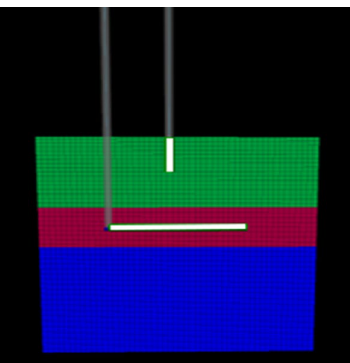
Fig. 2 A 2D view of the box model, showing the gas (green), oil (red) and water (blue) zones at initial conditions. The white lines depict the completion intervals for the gas and oil production wells